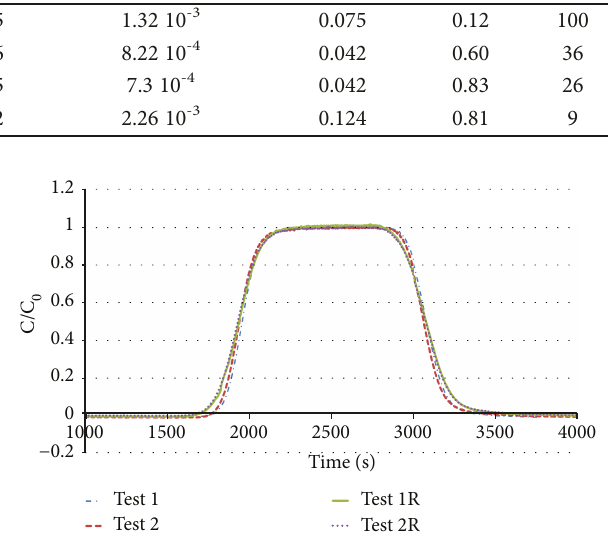
Table 2: Data regarding characterization of the porous materials and performed experiments with homogeneous column. Code of porous